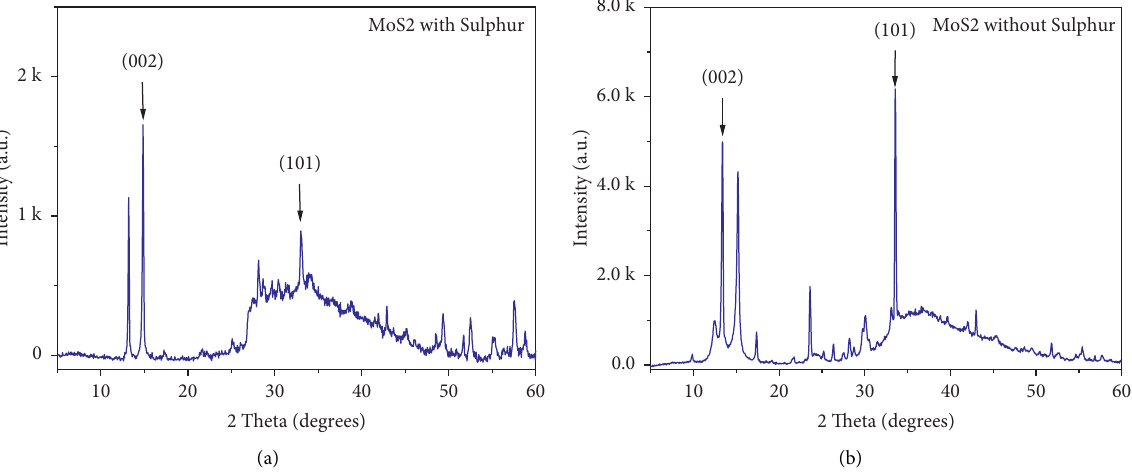
Figure 6: XRD of MoS 2 (a) with sulphur and (b) without sulphur.